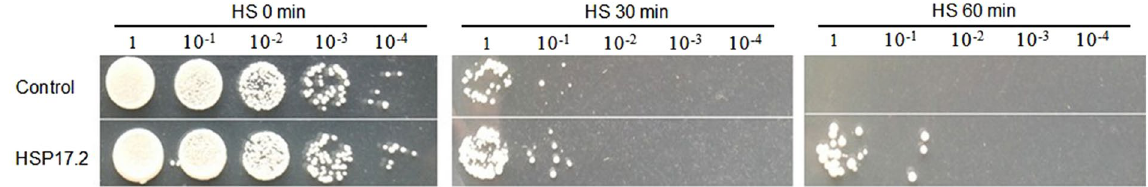
Figure 4. Heterologous expression of CsHSP17.2 in P. pastoris under heat shock (HS). Control indicates the transformant harboring the empty vector pPIC3.5 K, and HSP17.2 indicates the P. pastoris strains with recombinant plasmid pPIC3.5K-HSP17.2.